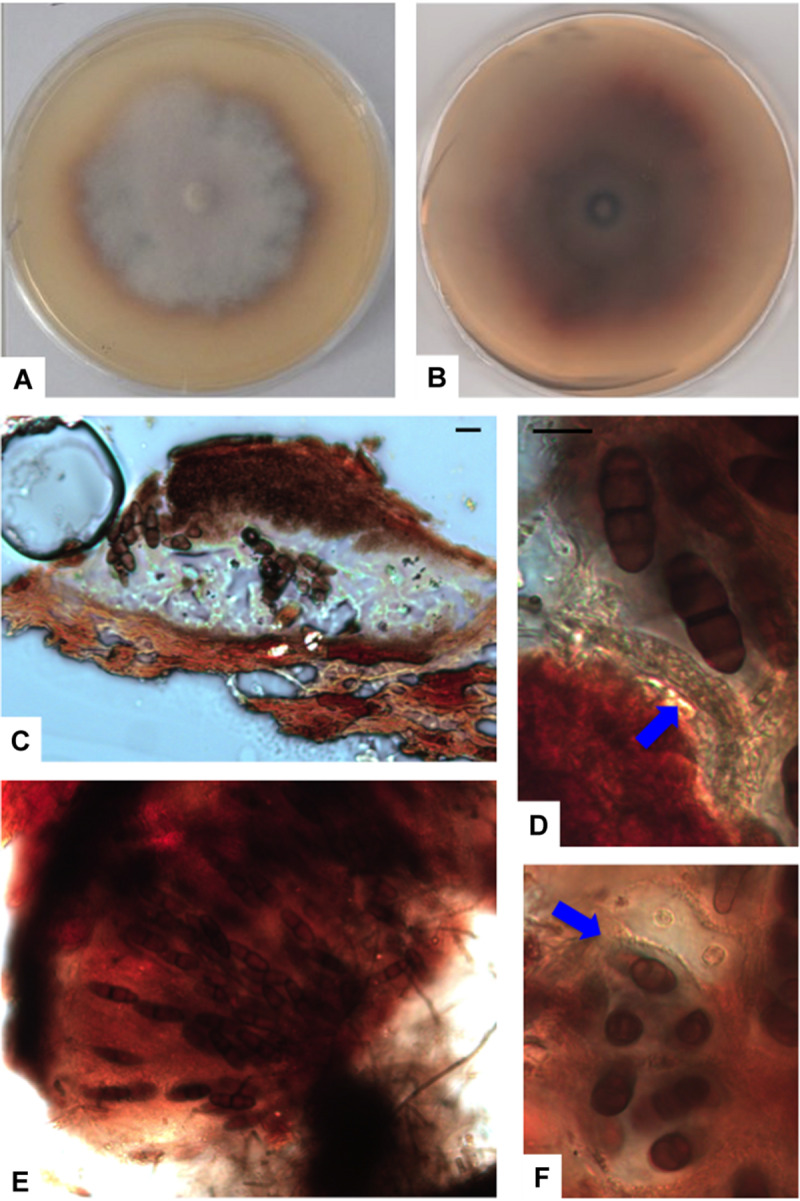
Paralulworthia posidoniae sp.nov. 28-days-old colony incubated at 21°C on MEASW (A) and reverse (B); ascoma (C), clavate young ascus (D, red arrow); mature asci in the ascoma (E), transversal section of asci with ascospores (F, red arrow). Scale bars 20 μm (C,E,F), 10 μm (D).